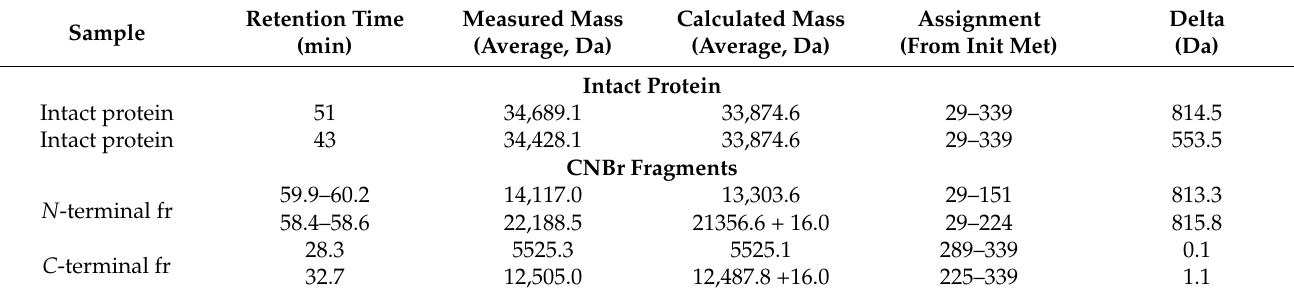
Figure 6. Analysis of the His-D2/ ∆ CP47 preparation using a reverse-phased HPLC column PLRP/S in combination with high resolution (HR) mass spectrometry. The separation was performed at 40 ◦ C, and elution was performed using a gradient from 0.1% trifluoroacetic acid (TFA) in water to a mixture (50/50) of acetonitrile containing 0.1% TFA and isopropanol. The eluted protein fractions were analyzed by offline nanospray HR MS, and species eluted at 43 and 51 min, which were found to contain Ycf48 by bottom–up MS, were selected for further analysis. Table 1. MS analysis of the intact Ycf48 and its fragments after cyanogen bromide cleavage. Cleavage of the protein after methionine residues resulted in the generation of fragments that were detected by MS. The results confirmed the putative N -terminal modification with a PTM involving the addition of 813–816 (or 553) and cleavage of the last three amino acid residues. N -terminal fragments were identified as homoserine lactones and +16.0 stands for methionine